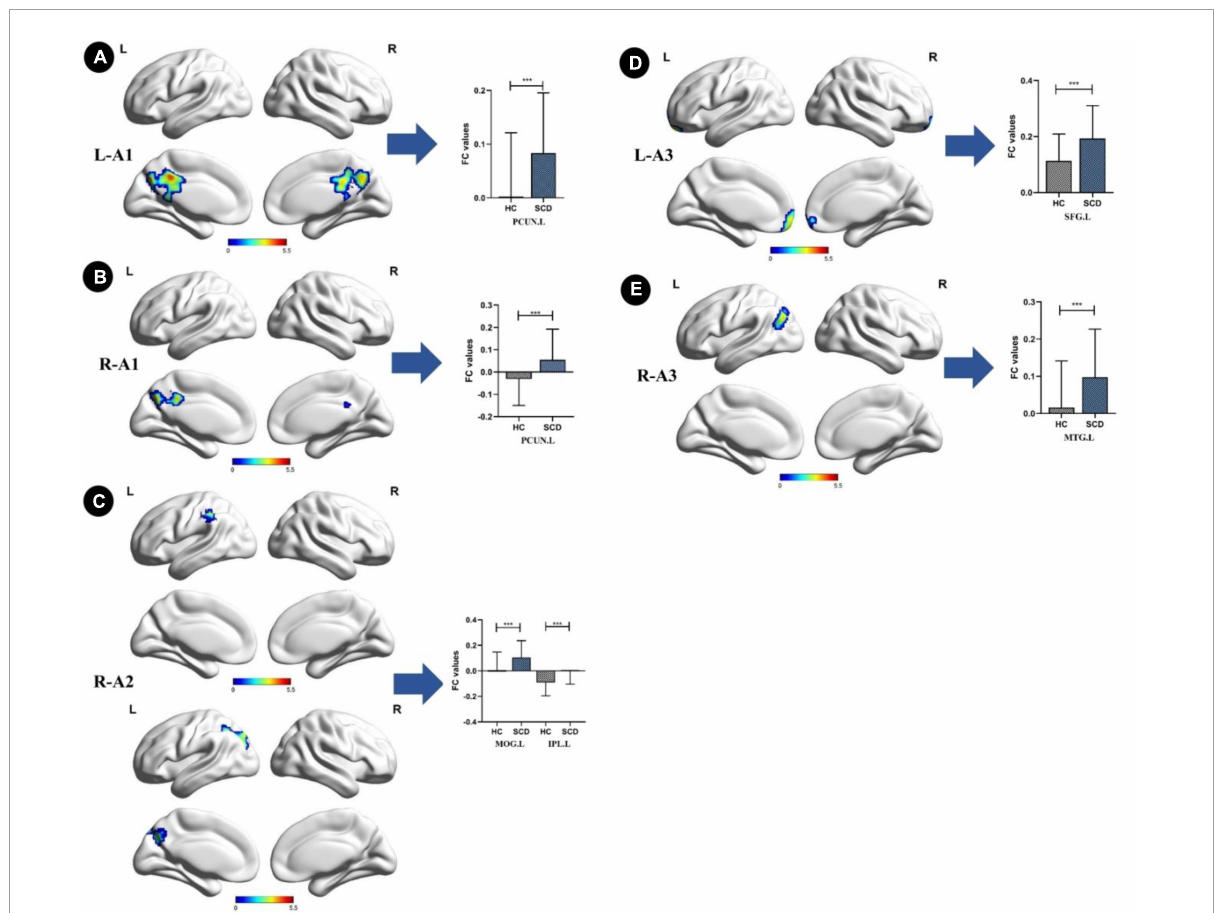
FIGURE2 Anterior cingulate cortex subregions functional connectivity in patients with subjective cognitive decline (SCD) compared to healthy control (HC). (A) Functional connectivity (FC) of left caudal anterior cingulate cortex subregion (L-A1) between HC and SCD patients. A bar chart indicating the quantitative comparison of FC between these regions. (B) FC of right caudal anterior cingulate cortex subregion (R-A1) between HC and SCD patients. A bar chart indicating the quantitative comparison of FC between these regions. (C) FC of right dorsal anterior cingulate cortex subregion (R-A2) between HC and SCD patients. A bar chart indicating the quantitative comparison of FC between these regions. (D) FC of left subgenual anterior cingulate cortex subregion (L-A3) between HC and SCD patients. A bar chart indicating the quantitative comparison of FC between these regions. (E) FC of right subgenual anterior cingulate cortex subregion (R-A3) between HC and SCD patients. A bar chart indicating the quantitative comparison of FC between these regions. only the subnetworks that show between-group differences are shown here. All results are displayed after adjusting for age, sex, and education. A threshold of p < 0.05 was applied, with a TFCE-FWE correction with cluster size > 200 mm 3 . FC, functional connectivity; HC, healthy controls; SCD, subjective cognitive decline; PCUN.L, left precuneus; MOG.L, left middle occipital gyrus; IPL.L, left inferior parietal lobule; SFG.L, left superior frontal gyrus; MTG.L, left middle temporal gyrus. *** p < 0.05.